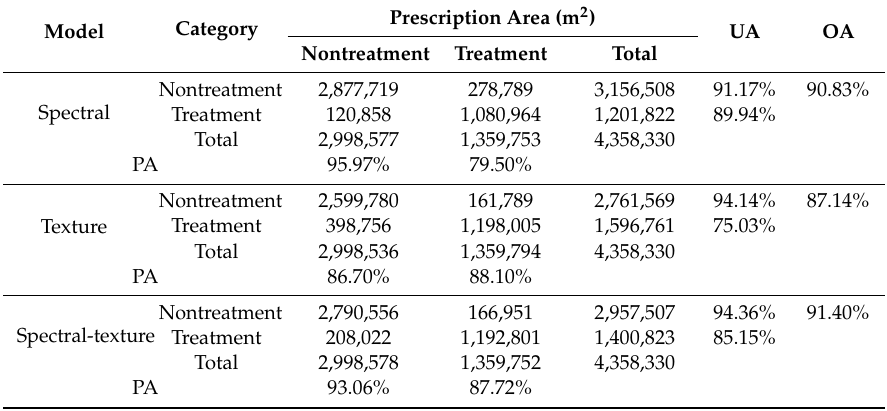
Table 8. Error matrices for prescription maps generated by binary logistic regression (BLR) models for the whole study